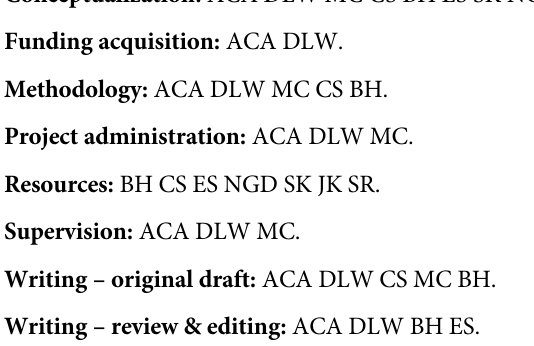
S1 Table. Propargyl-linked antifolates inhibit the Mtb DHFR enzyme and growth of Mtb. S2 Table. MIC values against M . smegmatis and overexpressing strains. S3 Table. Resistance pattern of organisms tested against DHFR